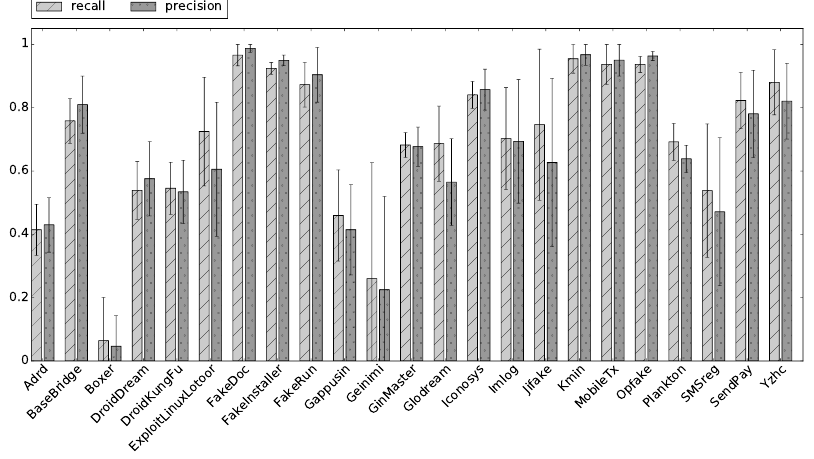
Figure 4. Normalized confusion matrix of the SVM classifier.